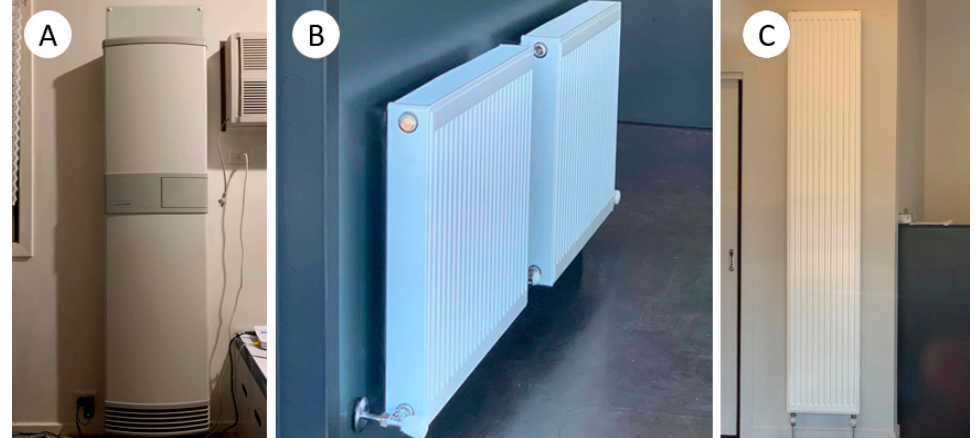
Figure 3. ( A ) A convective heater. ( B ) A hydronic radiator. ( C ) A modern hydronic radiator panel.